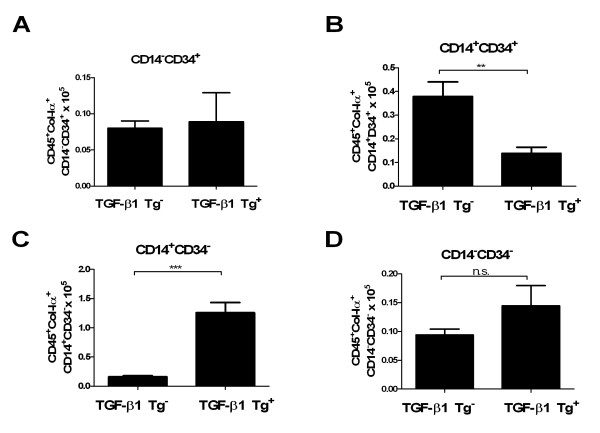
Expression of cell surface markers on CD45+ collagen (Col)-Iα1+ cells from transforming growth factor (TGF)-β1-exposed murine lung. (a) Quantities of CD45+Col-Iα1+CD14-CD34+ cells did not differ between the TGF-β1 Tg- and Tg+ mice. (b) CD45+Col-Iα1+CD14+CD34+ cells were significantly reduced in the TGF-β1 Tg+ mice. (c) CD45+Col-Iα1+CD14+CD34- cells were significantly increased in the TGF-β1 Tg+ mice. (d) CD45+Col-Iα1+CD14-CD34-cells did not differ between TGF-β1 Tg- and TGF-β1 Tg+ mice. N = 5 mice/group, images are representative of all animals. **P < 0.01, ***P < 0.001.